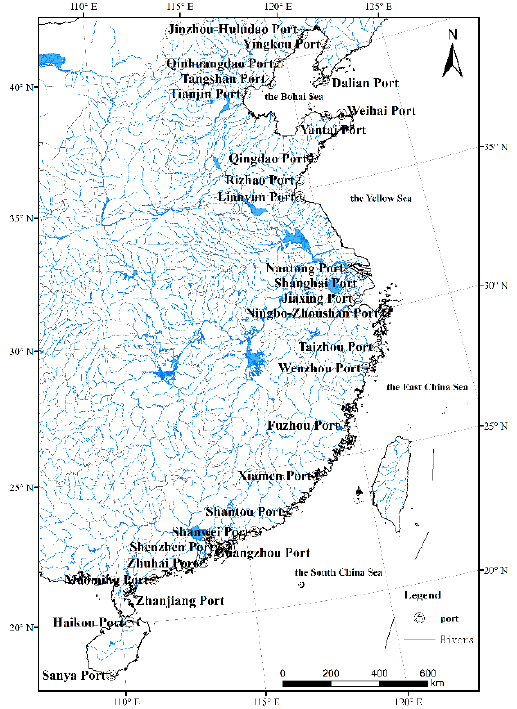
Figure 1. Research cases: the 28 coastal ports in China.